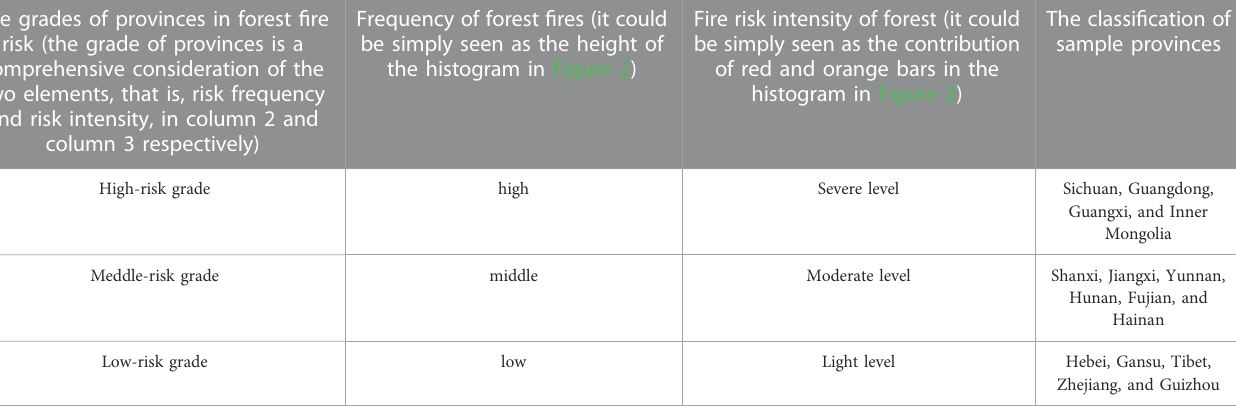
Frequency of forest fi res (it could be simply seen as the height of the histogram in Figure 2)